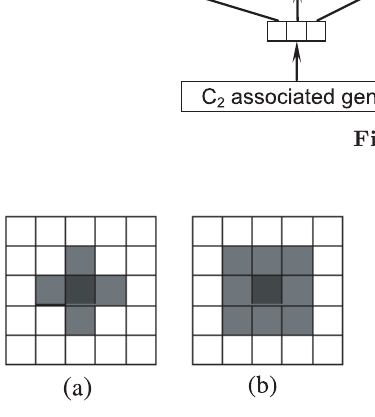
Fig. 5. Cell neighborhoods (a) Von Neumann (b)